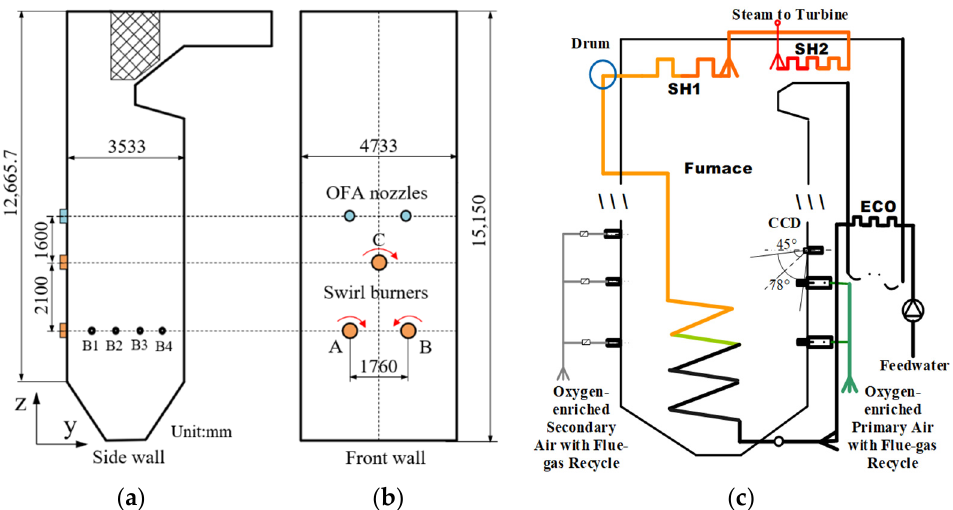
Figure 1. Structure of the boiler: ( a ) z–y plane of the furnace, ( b ) z–x plane of the furnace, and the thermodynamic system diagram ( c ). OFA nozzles: over-fire air nozzles; SH1, 2: 1-stage superheater, 2-stage superheater; CCD: charge-coupled device; ECO: economizer.